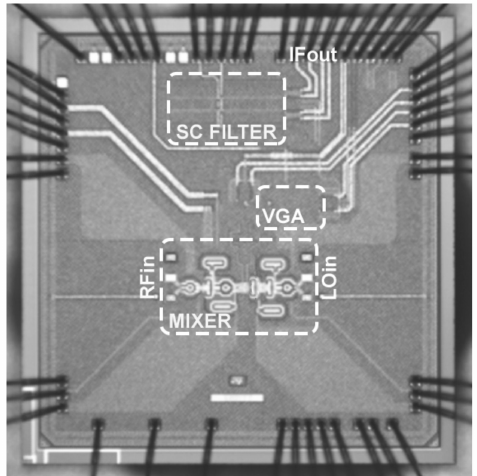
Figure 5. Micrograph of the seventh order SC low-pass filter in a complete 77-GHz radar receiver. Reproduced from [25]. Copyright 2021,